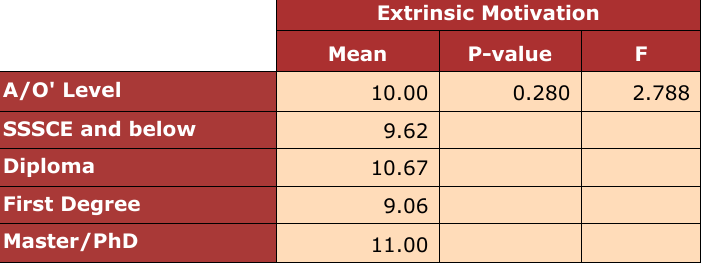
Table 7. Extrinsic motivation across Educational Level [One-Way Analysis of Variance (ANOVA)]